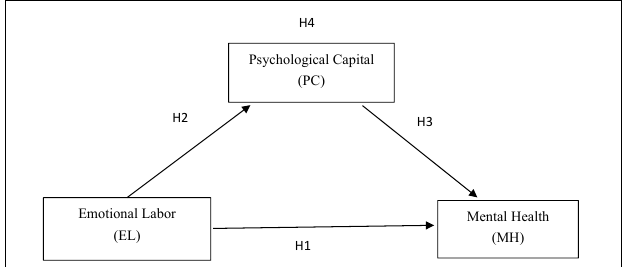
FIGURE 1 | Research model. Emotional Labor (EL) includes three strategies: EL1, surface acting; EL2, expression of naturally felt emotions; EL3, deep